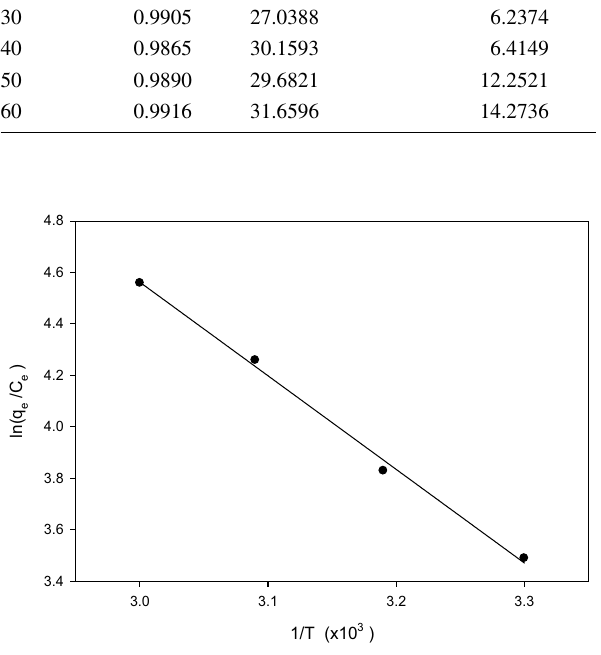
Fig. 8 Plot of ln( q C T (× 10 3 )for adsorption of aqueous e / e ) versus 1/ methylene blue on coconut coir dust with varying temperature